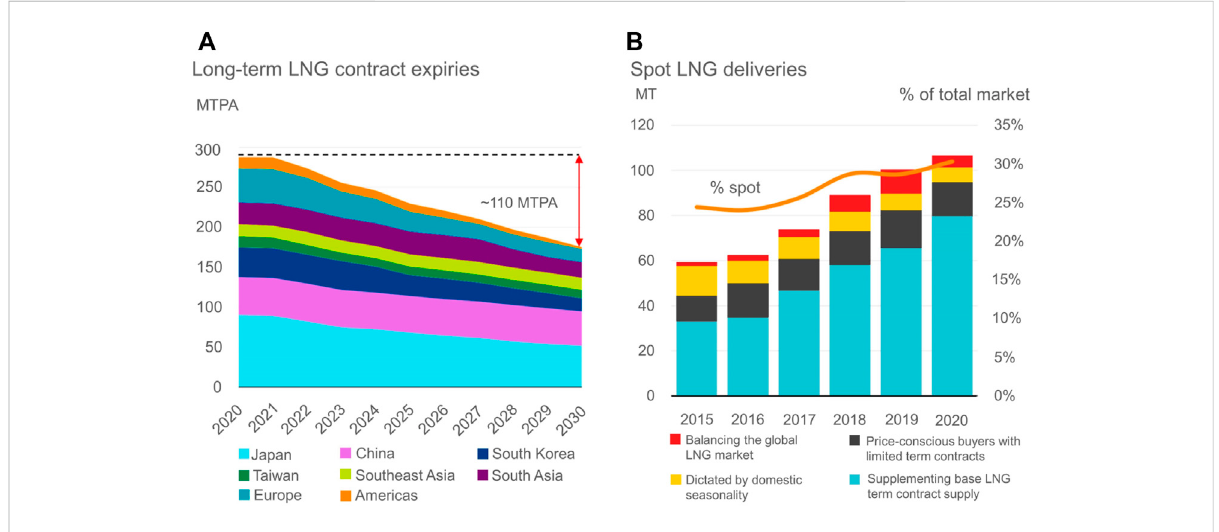
FIGURE 2 LNG trade in 2021 (Shell, 2021). MTPA, million tons per annum; MT, million